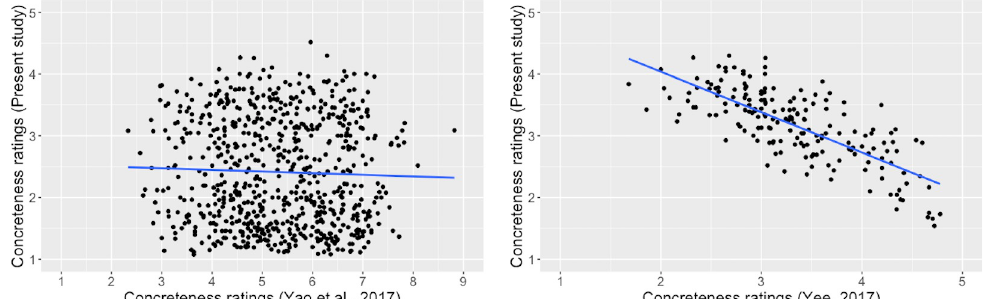
Fig 5. a. Correlation of the present concreteness ratings and concreteness ratings by Yao et al. [31], r = -.04, p = .34. (in Yao et al. [31], “1” represented “very abstract”, and “9” represented “very concrete”; in the present study, “1” represented “very concrete”, and “5” represented “very abstract”.). b. Correlation of the present concreteness ratings and concreteness ratings by Yee [32], r = -.75, p < .0001. (in Yee [32], “1” represented “very abstract”, and “5” represented “very concrete”; in the present study, “1” represented “very concrete”, and “5” represented “very abstract”.).